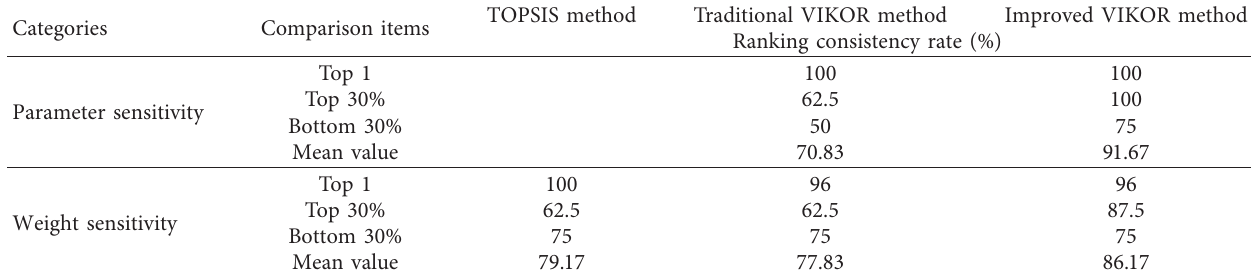
Table 9: Results of the sensitivity